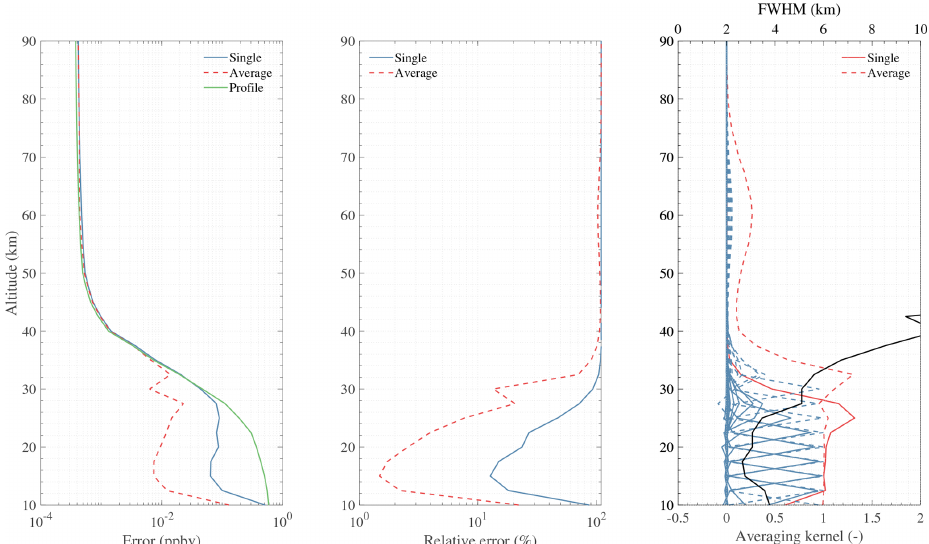
Figure 21. Simulation results of CH 3 Cl retrieval using 649.5GHz lines. “Single” and “Average” represent the retrieval error using different noise. “Profile” represents the typical profile used in the simulation. The black solid line in the last panel represents the FWHM (i.e. vertical